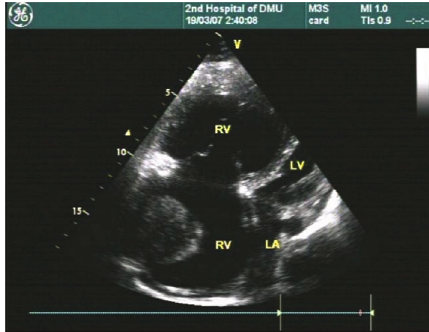
Figure 2: Apical four-chamber view, right atrium and right ventricle enlarged, sonographic image of right atrium thrombus. Table 3: Blood gas analysis and comparison of TTE indexes in 39 patients with normotensive pulmonary embolism (